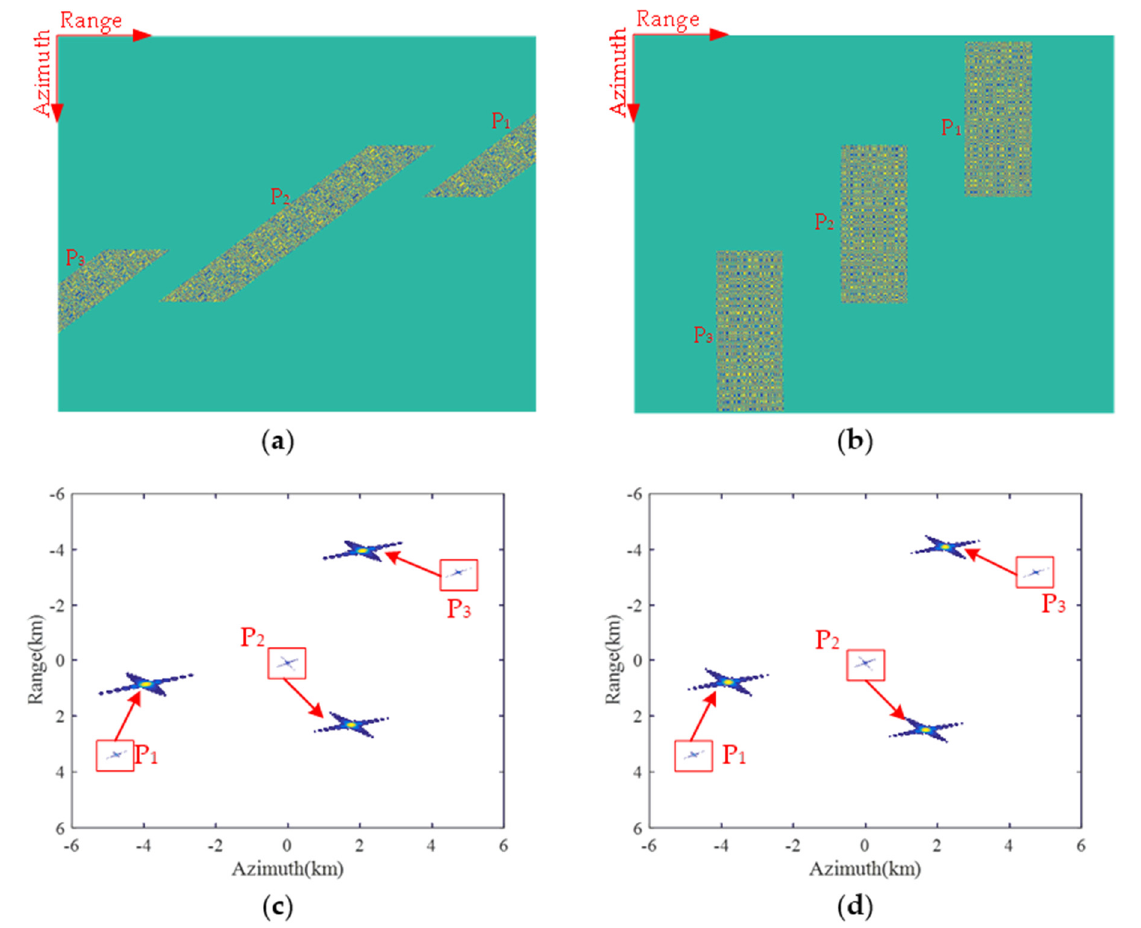
Figure 18. Simulation results of the fixed PRF and CV-PRF schemes. ( a ) The real part of echo data with the fixed PRF scheme; ( b ) the real part of echo data with the CV-PRF scheme; ( c ) imaging results with the fixed PRF scheme; ( d ) imaging results with the CV-PRF